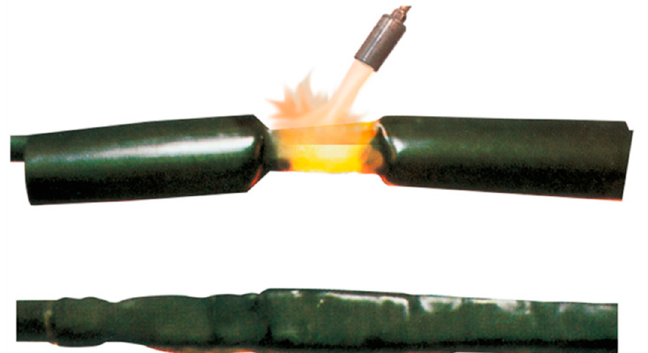
Figure 1. An example of a heat-shrinkable cable joint during its installation.